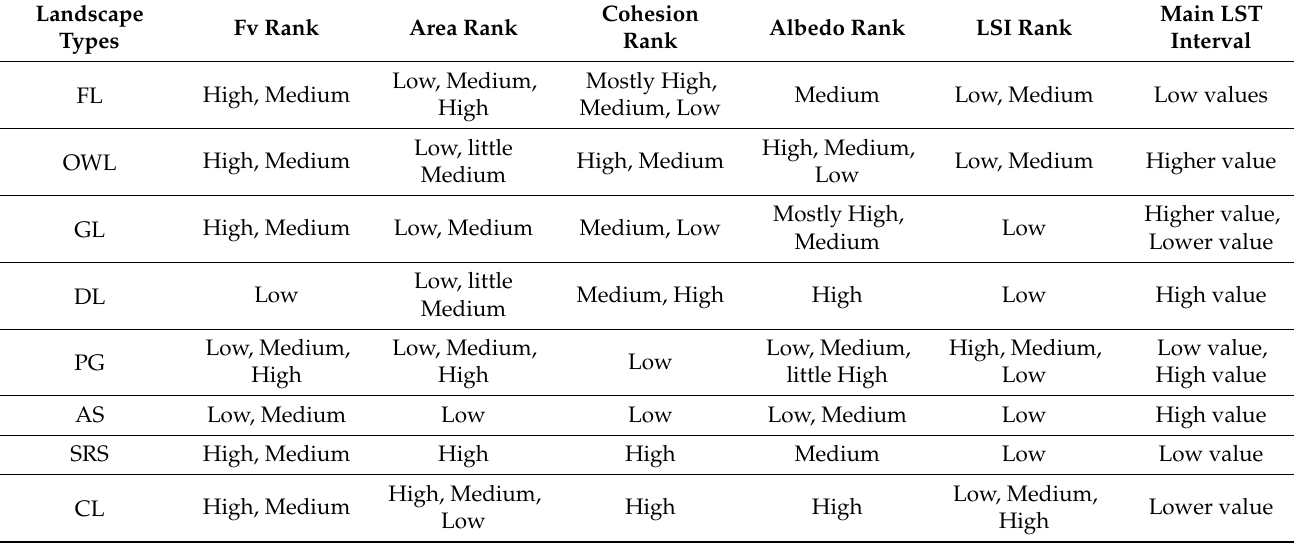
Table 11. Morphological rank of various greenspace types corresponding to LST distribution in the riverfront